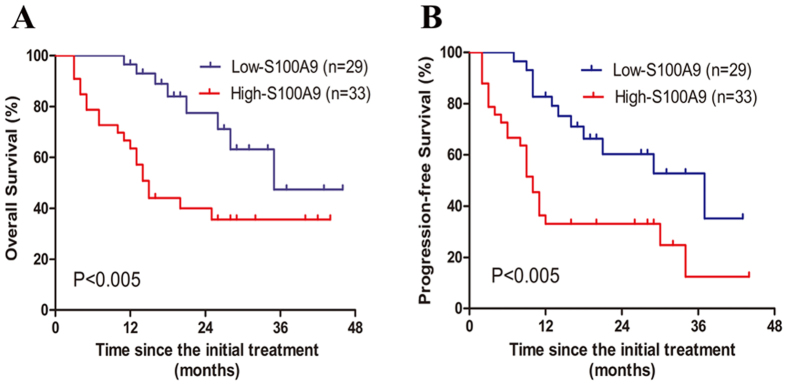
Survival of low-S100A9 group and high-S100A9 group.(A) High levels of S100A9 in serum were associated with inferior overall survival (P = 0.0036). (B) High levels of S100A9 in serum were associated with inferior progression-free survival (P = 0.0019).